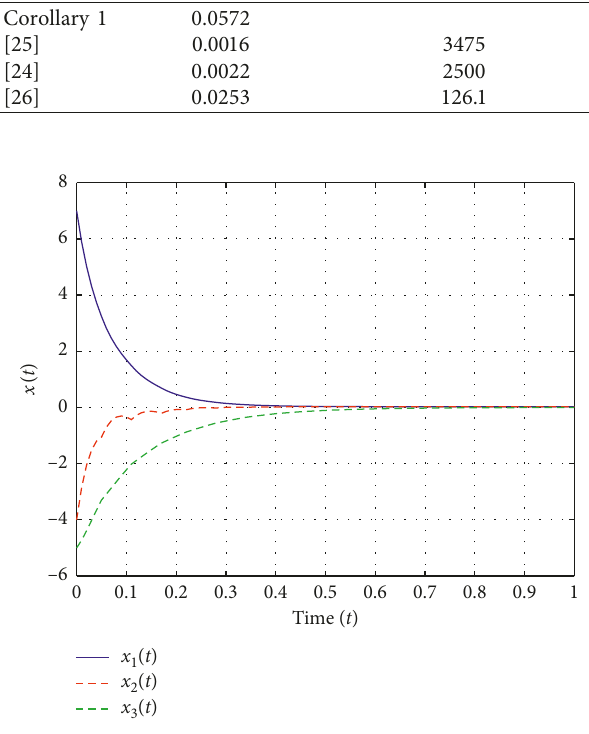
Figure 9: State path of the fuzzy chaotic system (72) with control input.